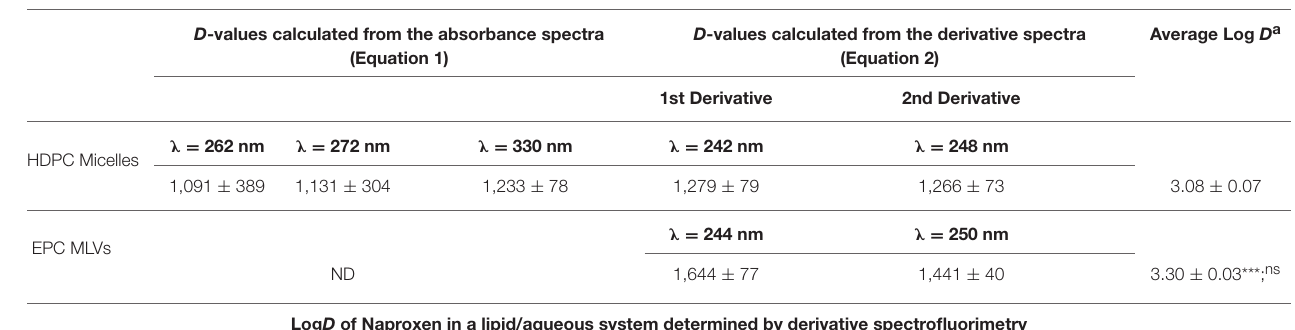
TABLE 1 | Values of lipid/aqueous distribution coefficient (D and LogD) of Naproxen obtained from the absorbance spectra and from the derivative of the absorbance spectra. Log D of Naproxen in a lipid/aqueous system determined by spectrophotometry and derivative spectrophotometry D -values calculated from the absorbance spectra D -values calculated from the derivative spectra (Equation 1) (Equation